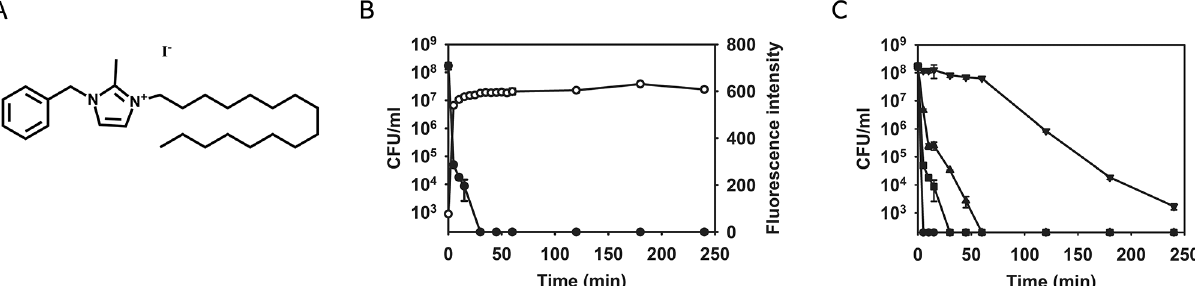
Fig 4. NH125 kills MRSA persisters by inducing membrane permeabilization. (A) The chemical structure of NH125. (B) MRSA persisters were treated with 10 μ g/mL NH125. Membrane permeabilization (open circles) was measured spectrophotometrically by monitoring the uptake of SYTOX Green (excitation wavelength of 485 nm and an emission wavelength of 525 nm). Colony forming unit counts of persisters (solid circles) was measured by serial dilution and plating on TSA plates. (C) MRSA persisters were treated with several concentrations of NH125: 10X MIC (20 μ g/mL, circles), 5X MIC (10 μ g/mL, squares), 2.5X MIC (5 μ g/mL, triangles), and 1X MIC (2 μ g/mL, inverted triangles). Colony forming unit counts of persisters was measured by serial dilution and plating on TSA plates. The data points on the x-axis are below the level of detection (2x10 2 CFU/mL). Results are shown as means ± s.d.; n = 3.